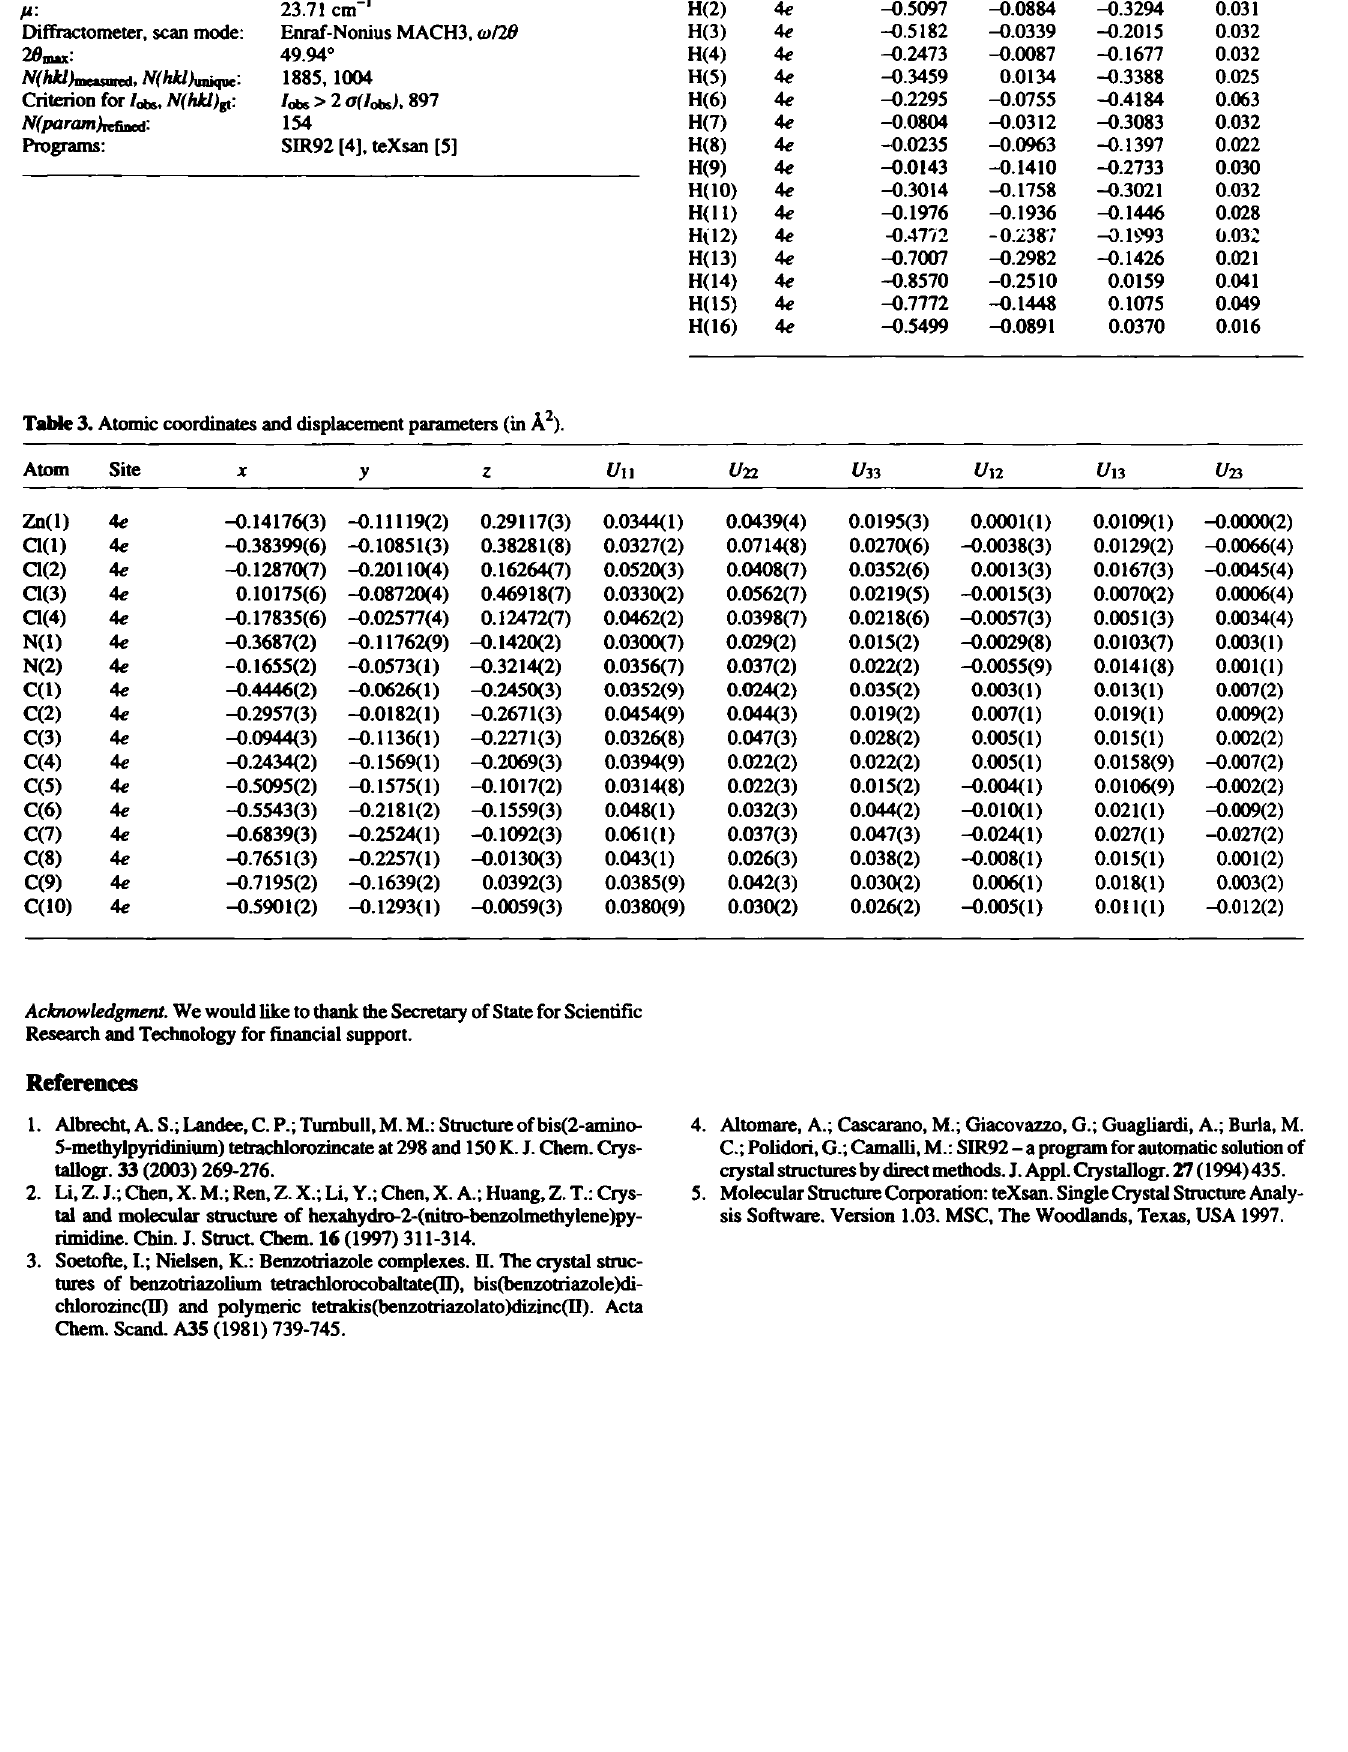
Table 3. Atomic coordinates and displacement parameters (in Ä 2